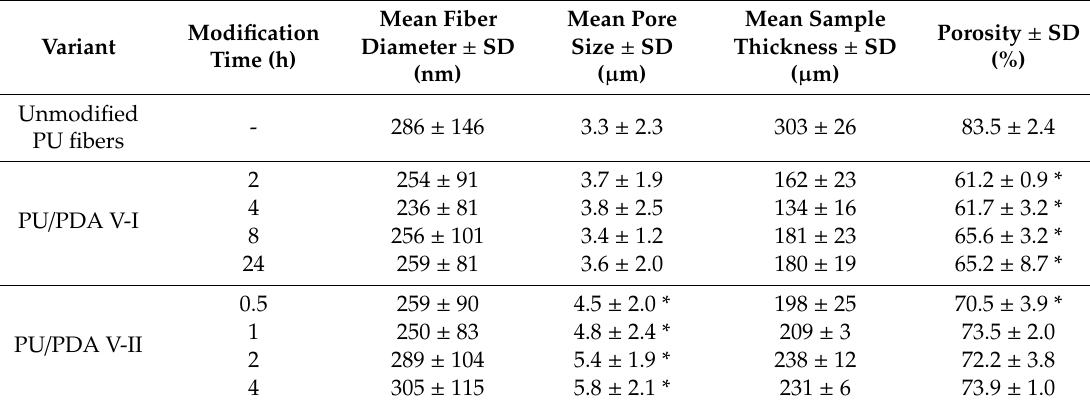
Table 1. Properties of unmodified and modified PU nanofibrous material.